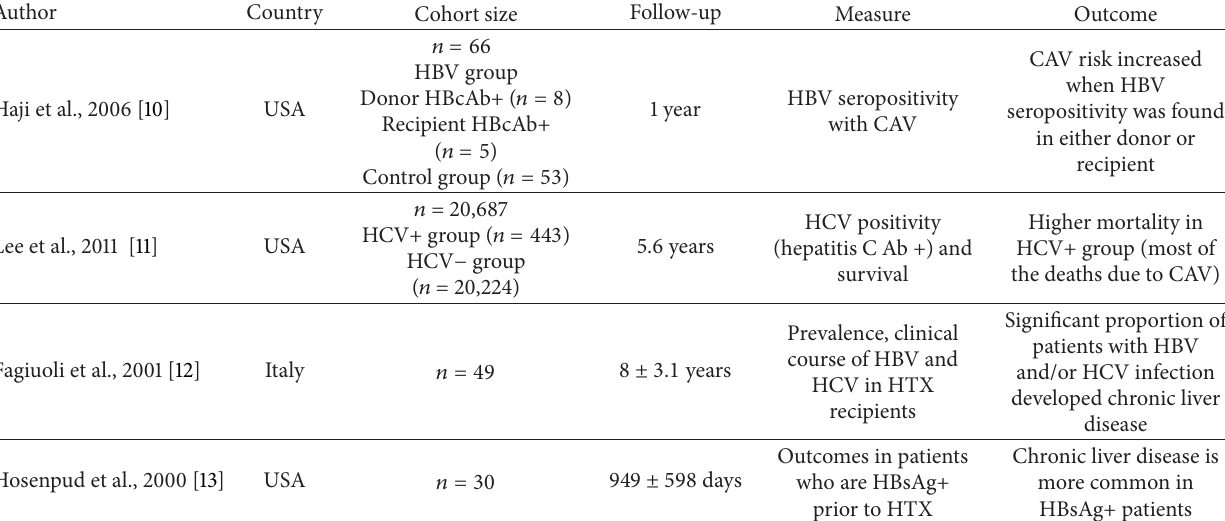
Table 1: Studies correlating HBV/HCV infection and clinical outcomes after cardiac